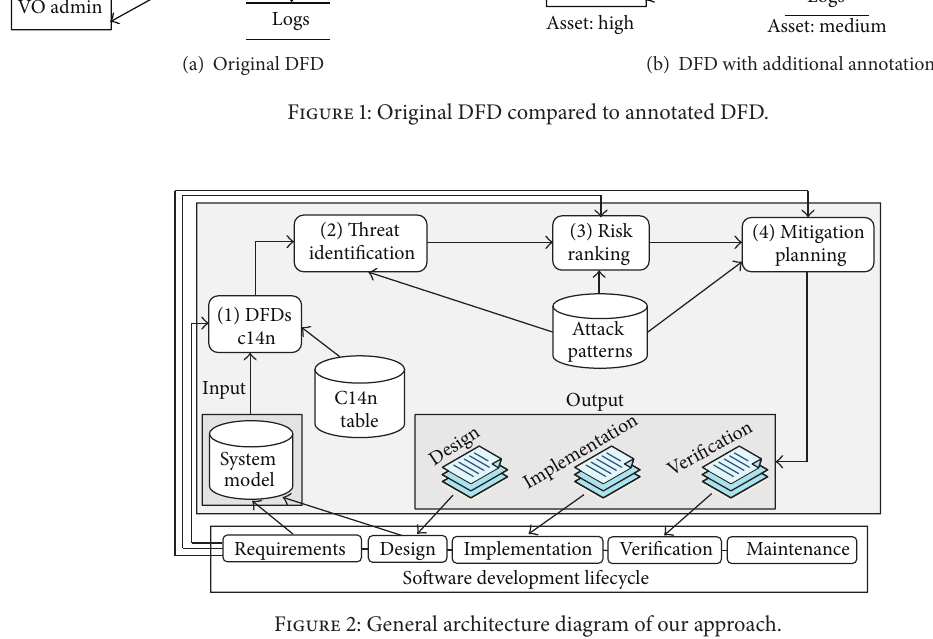
Figure 2: General architecture diagram of our approach.